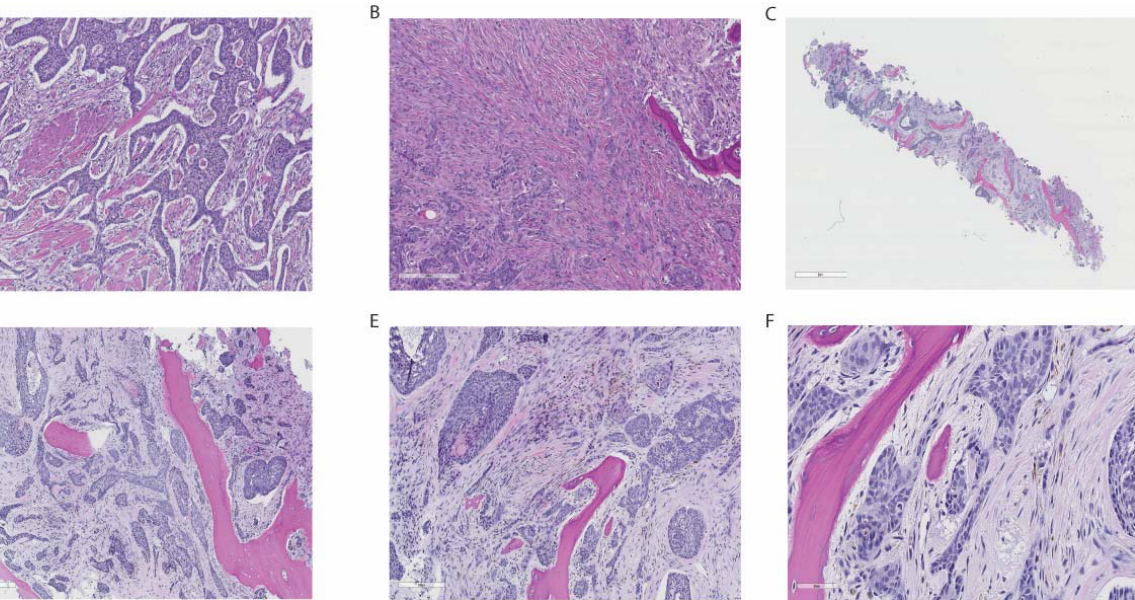
Figure 2. Histopathological features of metastatic BCC. The images show histopathological features from the original skin tumour ( A , B ), and from bone marrow biopsy with metastases ( C – F ). ( A ) Tumour showing irregular growth of basaloid tumour islets with palisading of nuclei and cleft formation peripherally in the tumour islets. ( B ) Strikingly infiltrative growth pattern (morphoea ‐ like) with invasion and destruction of rib bone tissue. ( C ) Bone marrow biopsy low ‐ power view showing extensive infiltration of marrow spaces. ( D ) Bone marrow infiltrated by malignant tumour tissue growing in irregular islands. ( E ) Irregular tumour islands with destruction of bony trabeculae. ( F ) Tumour cells are medium sized with light eosinophilic cytoplasm with round to oval nuclei with somewhat uneven nucleus contour and palisading, compatible with metastatic BCC.